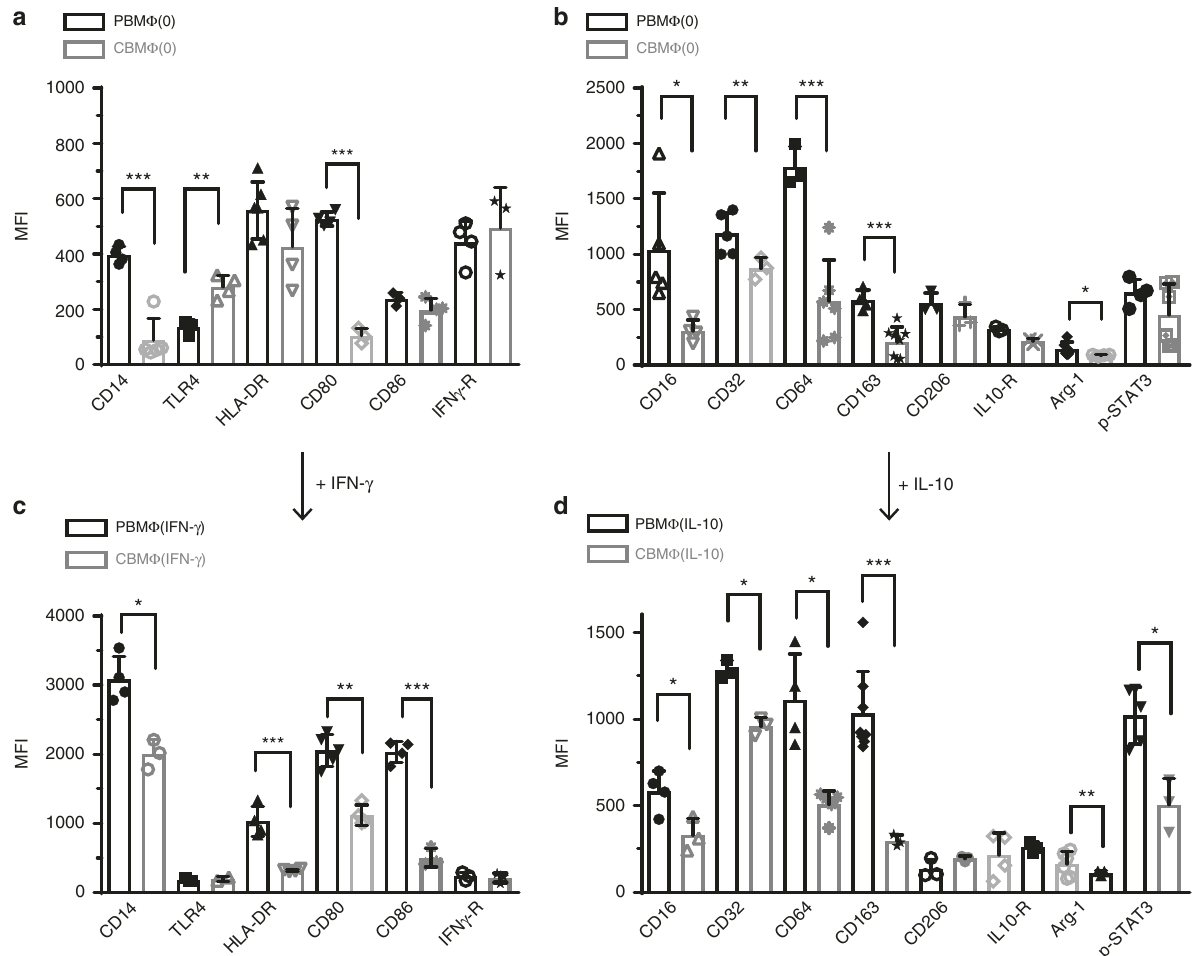
Fig. 1 Polarization toward M Φ (IFN- γ ) and M Φ (IL-10) states is altered in cord blood macrophages. a , b Polarization was induced in PBMC (peripheral blood- derived mononuclear cells, black-framed bars) and CBMC (cord blood-derived mononuclear cells, gray-framed bars) using 100 ng/ml hM-CSF for 72 h in RPMI (upper charts, M Φ (0)). Further polarization was achieved by addition of 50 ng/ml IFN-y (designated as M Φ (IFN- γ )) ( c ) or 10 ng of IL-10 (designated as M Φ (IL-10)) ( d ) for an additional 48 h. Immunotyping was performed by fl ow cytometric analysis detecting selected surface markers of traditional M1 – M Φ (left charts) and traditional M2 – M Φ (right charts). MFI was determined as a mean value; represented data show MFI of a marker — MFI of isotype control. Signi fi cance of reduced expression in CBM Φ was tested by utilizing the ANOVA test followed by Bonferroni post test ( N = 3 – 8, * p < 0.05; ** p < 0.01; *** p < 0.001). Bars indicate mean and error bars SD (detailed statistics in supplemental